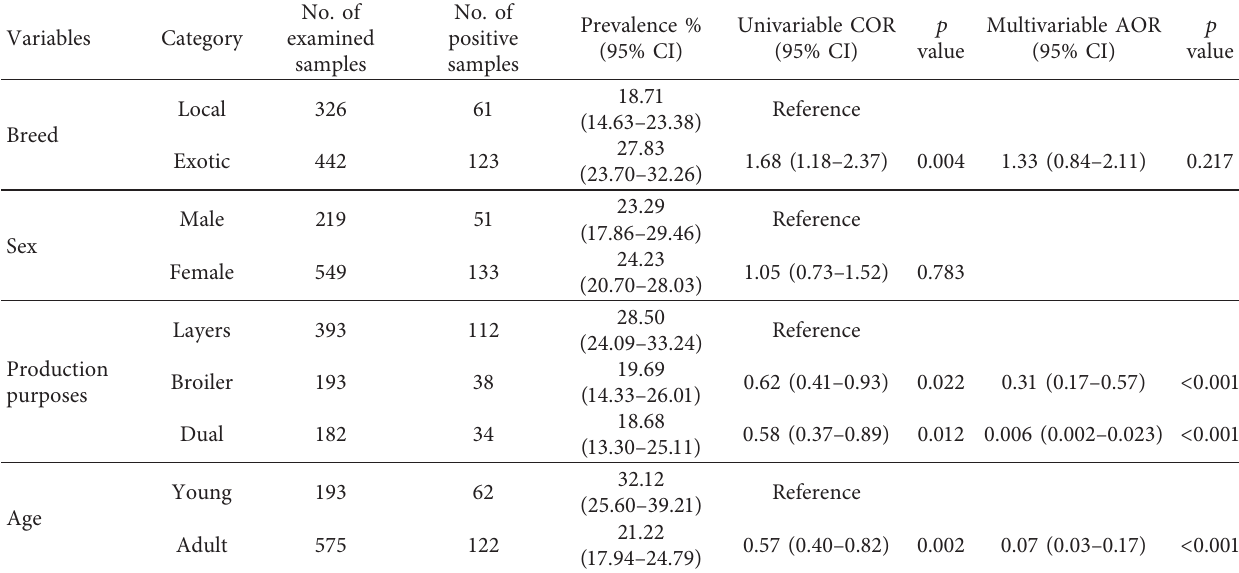
Table 2: Univariable and multivariable mixed-effect logistic regression analysis of host potential risk factors for infectious bronchitis virus.